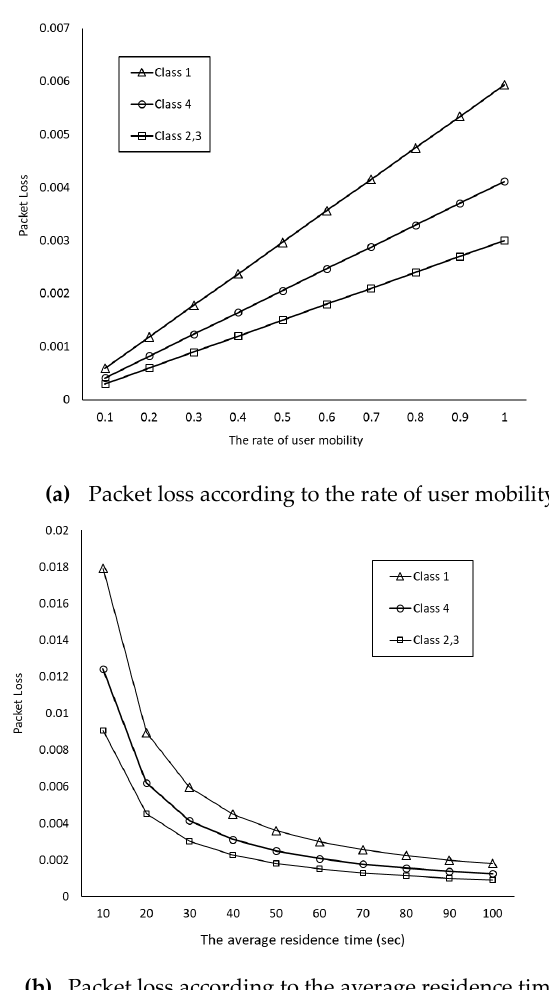
Figure 5. Packet loss according to the rate of user mobility ( a ) and average residence time ( b ).